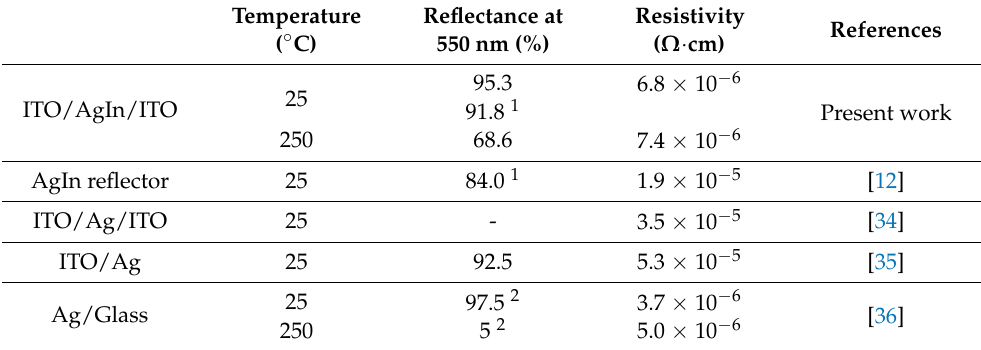
Table 1. Comparison of reflectance and resistivity of ITO/AgIn/ITO composite films with related films reported in the literature.